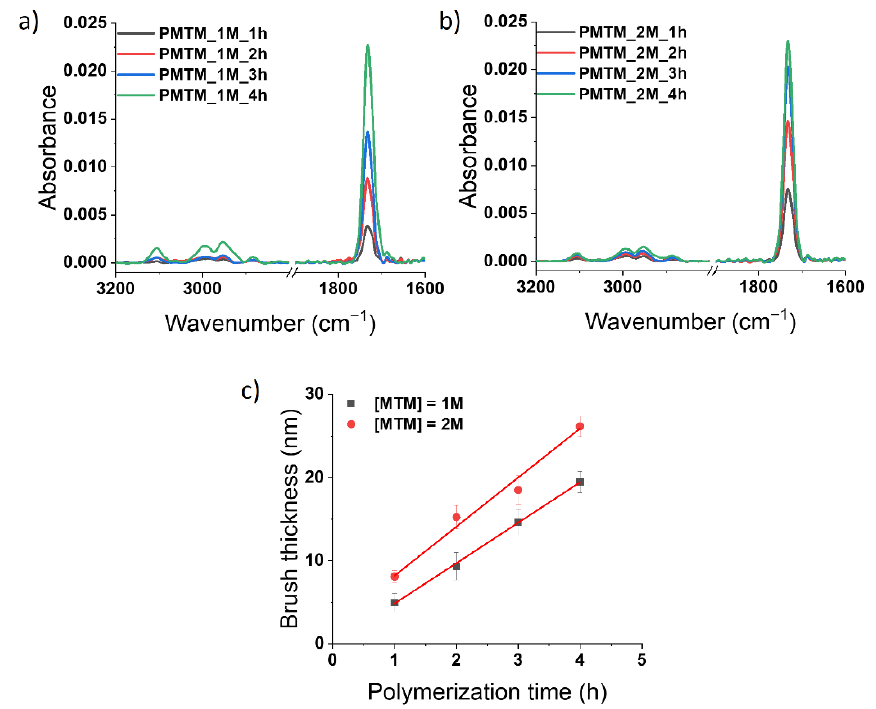
Figure 3. FTIR spectra of PMTM brushes captured after various times of metal-free SI-ATRP carried out using either 1 M ( a ) or 2 M ( b ) monomer concentration. The dependency of PMTM brush thickness (measured by AFM) vs. polymerization time ( c ).